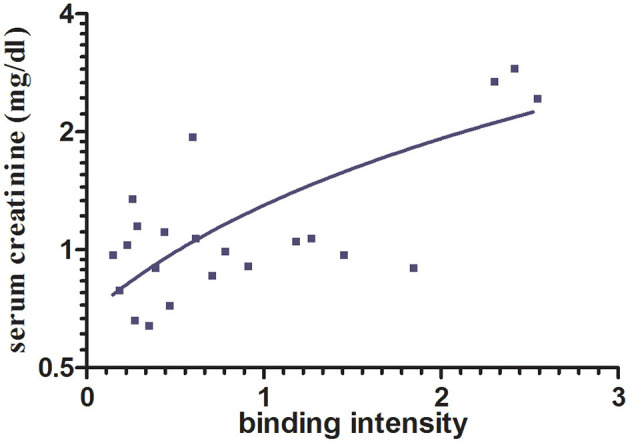
Association between immunoglobulin/LC binding to renal whole-cell lysate by ELISA and serum creatinine after 1-year follow-up. A significant association between immunoglobulin/LC binding intensity and the serum creatinine after 12 months (p < 0.0001, n = 22) was shown. Binding intensity was measured by photometrical density (OD 450 nm).